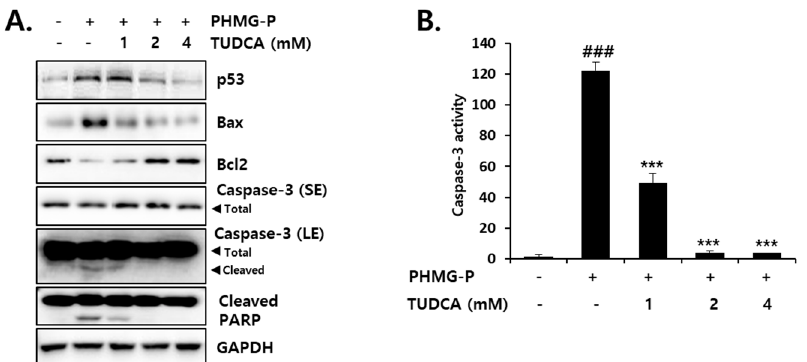
Figure 9. The inhibition of PHMG-P-induced apoptosis-related proteins and caspase-3 activity by the ER stress inhibitor, TUDCA. The cells were pretreated with TUDCA and then treated with 5 µg/mL PHMG-P for 24 h. ( A ) Western blotting was performed to determine apoptosis-related protein levels. GAPDH was used as an internal control. ( B ) The cell lysates were prepared and caspase activity was then measured using a fluorometric substrate. The results are presented as the mean ± SD of triplicate experiments. SE: short exposure, LE: long exposure. (### p < 0.001, significant versus control; *** p < 0.001, significant versus PHMG alone).